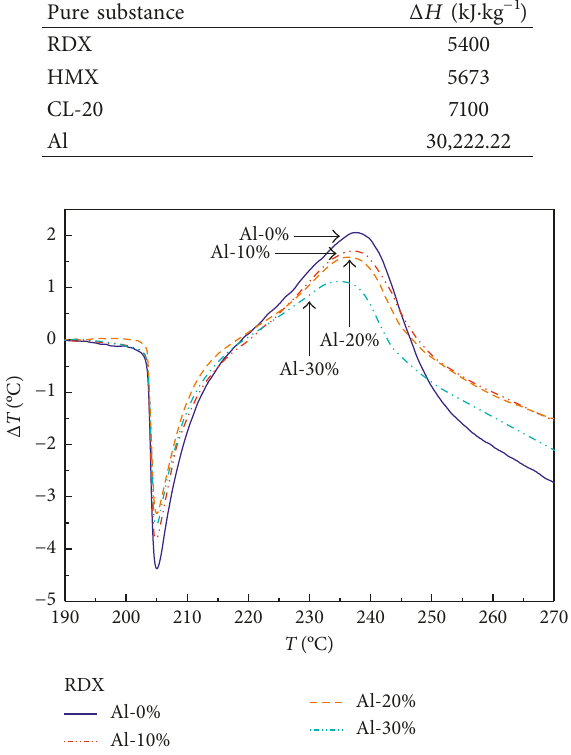
Figure 5: DTA curves of RDX with different mass percentages of Al